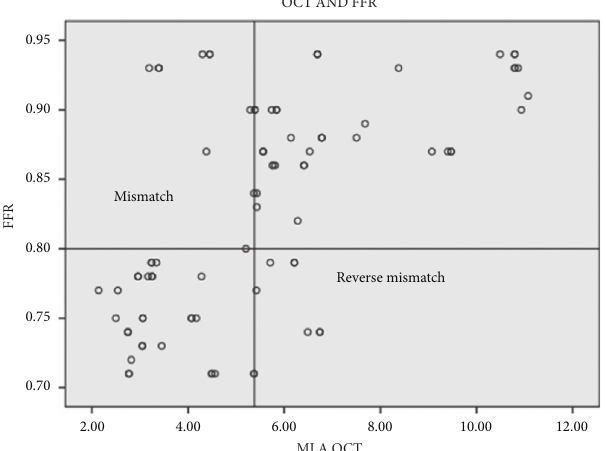
Figure 4: Scatter plot of FD-OCT MLA versus FFR values. The abbreviations are as in Figure